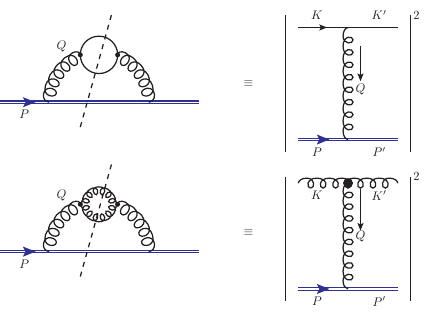
Figure 1. Here we have shown the equivalence of the t -channel scattering of heavy quarks due to thermally generated light quarks and gluons, qH → qH (left) and g H → g H (right). The scatterings can also be expressed as the cut (imaginary) part of the HQ self